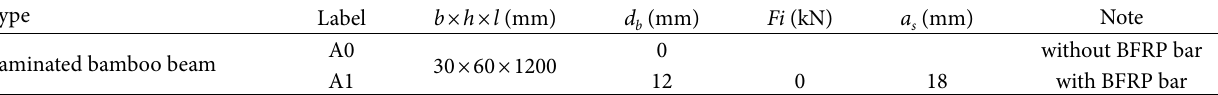
Table 2: Details of tested laminated bamboo beams applied with/without BFRP bar.